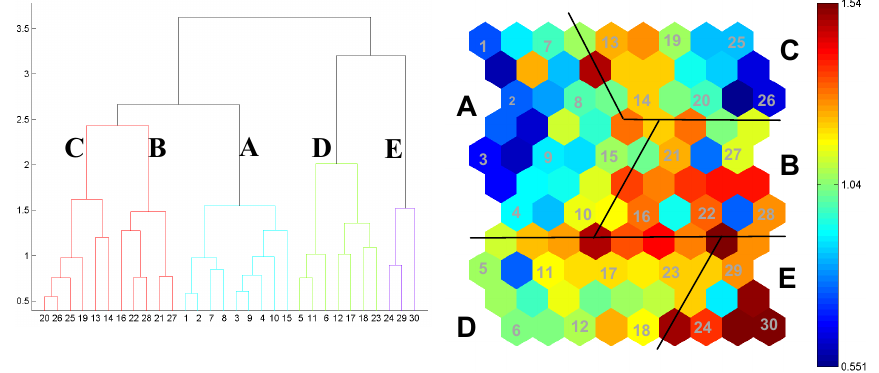
Fig. 5. Dendrogram on SOM and U-matrix with cluster. Numbers in the dendrogram correspond to neuron numbers on the U-matrix; capital letters indicate clusters.